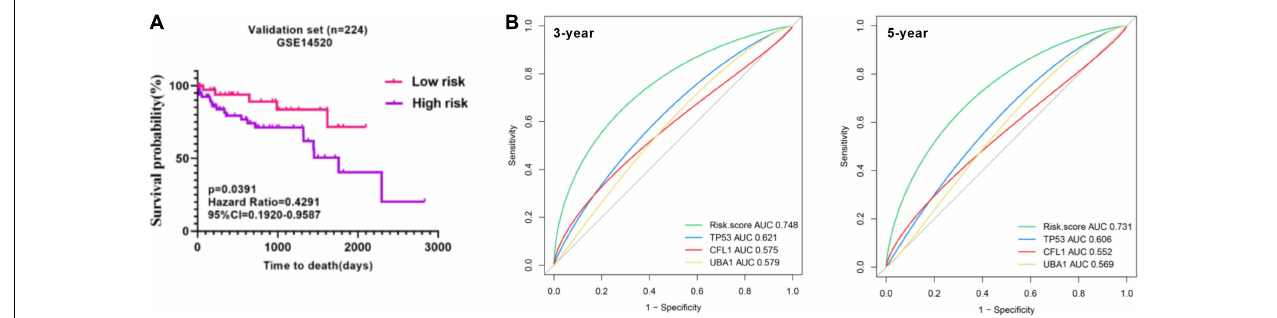
FIGURE 8 | Presentation of the three-gene signature in the validation cohort. (A) Kaplan–Meier plots were applied to visualize the OS probabilities for the high-risk versus low-risk patients in the validation set (GSE14520). (B) Time-dependent ROC analysis of the three-gene signature in the validation set. OS, overall survival; ROC, receiver operating